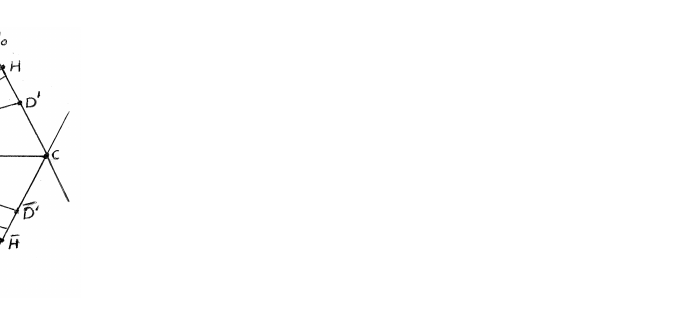
Figure 9. The regular stellated n -gon K ∗ two of whose sides are CD (cid:48) and CD (cid:48) . π − n 1 π , it follows that | H | = | C | sin π n 1 Since ∠ COH = 1 n 2 the center O of K ∗ to the line (cid:96) 0 containing the side CD (cid:48) , or to the line (cid:96) 1 containing n 1 ] π i is the closest point H on (cid:96) ) e [ 1 2 − the side CD (cid:48) . So u 0 = ( | C | sin π n 1 n n